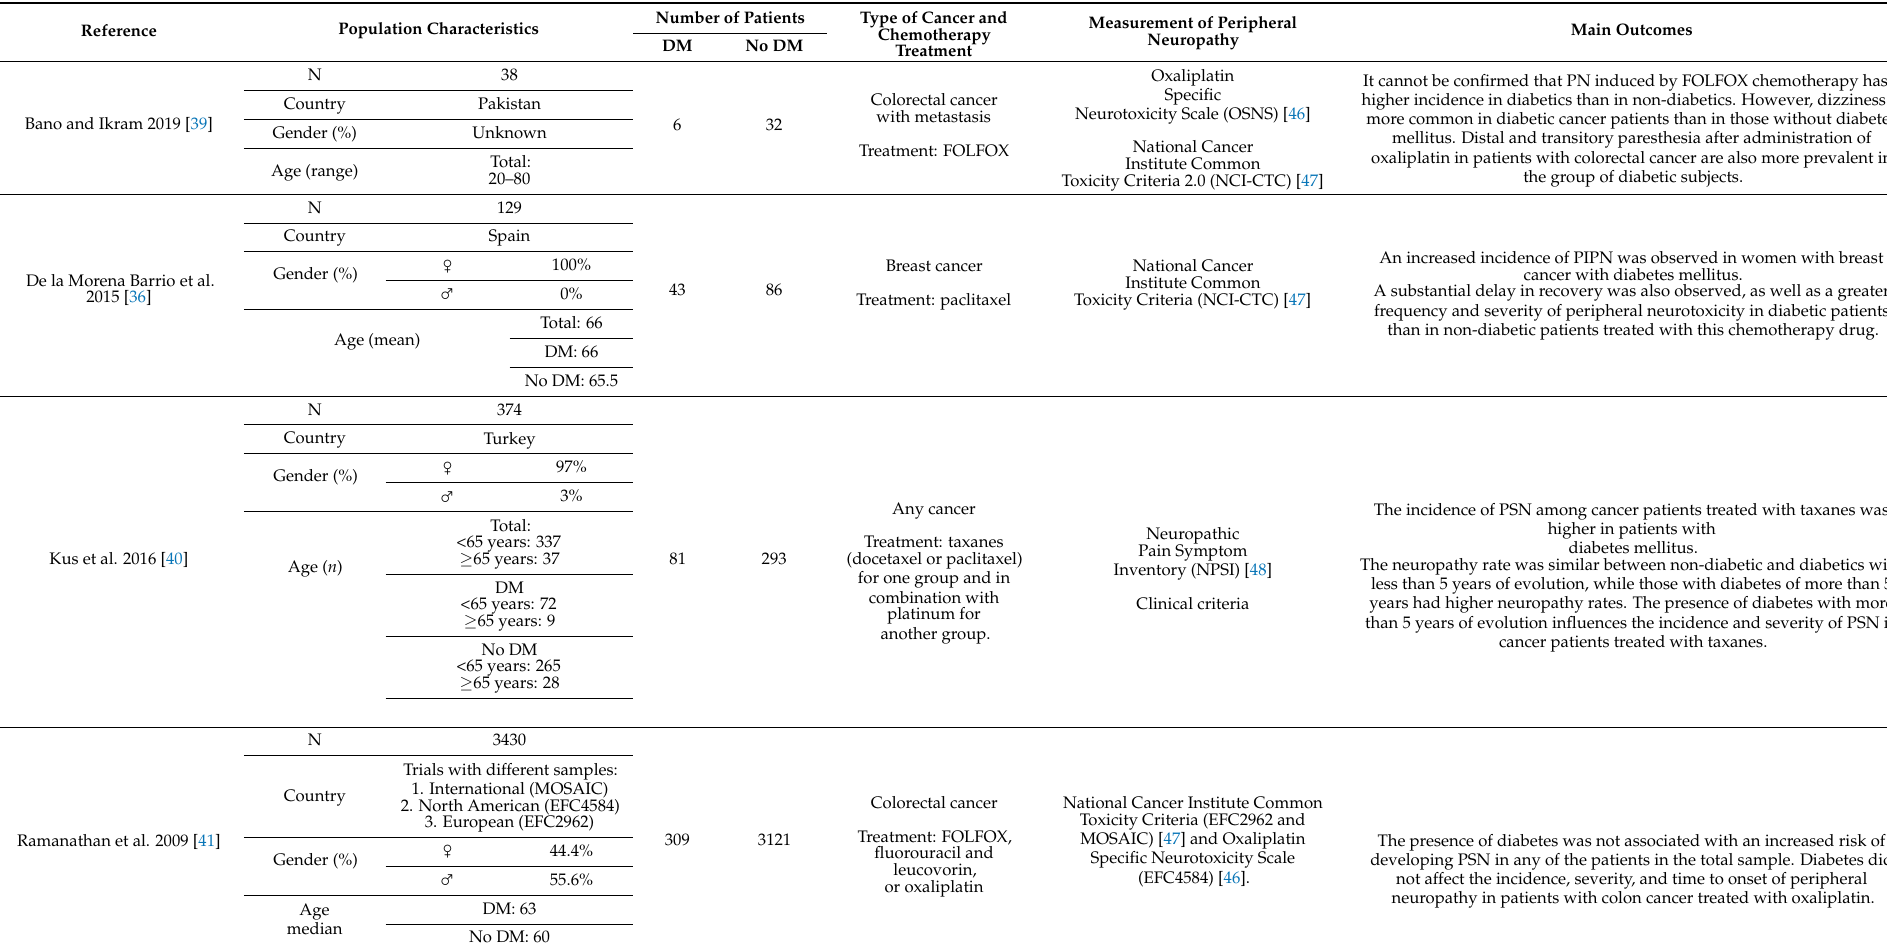
Table 2. Peripheral neuropathy induced by chemotherapy: differences between selected